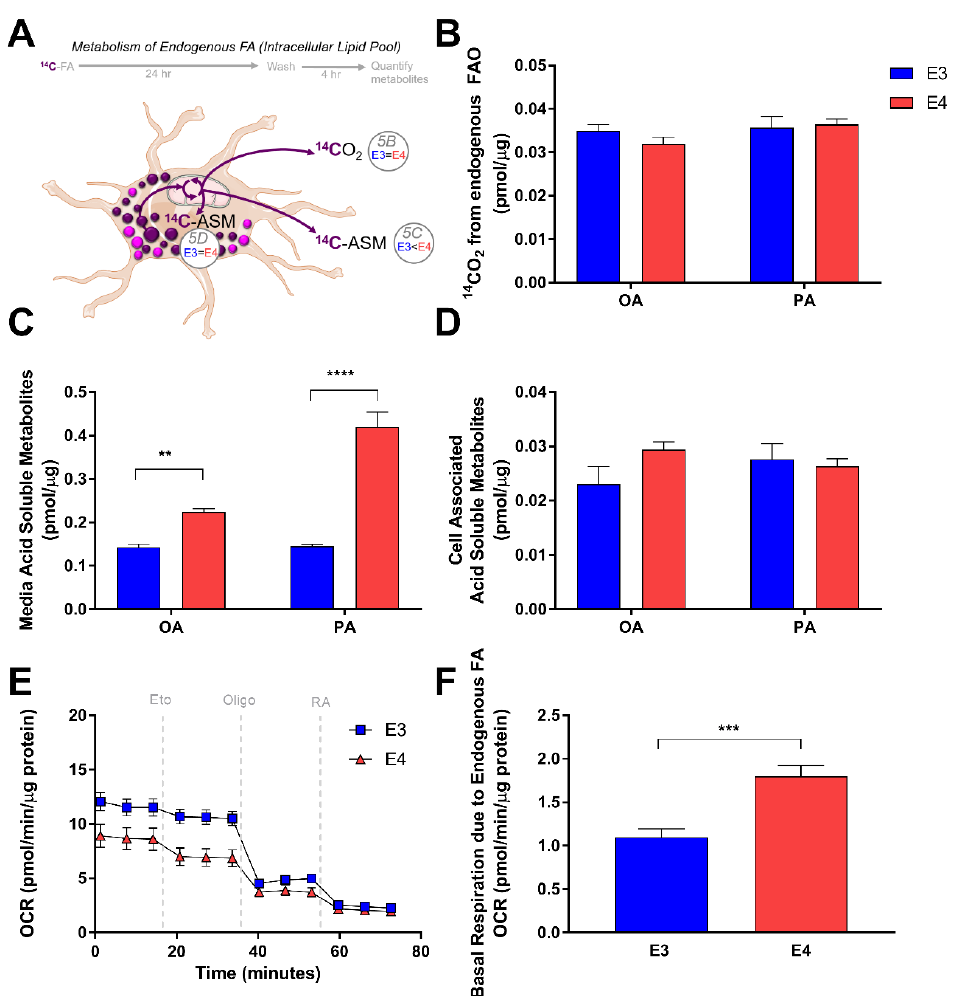
Figure 5. E4 astrocytes oxidize more endogenous fatty acids. ( A ) Schematic and time-course of pulse-chase experiment to determine oxidation of endogenous fatty acids.. ( B ) E3 and E4 astrocytes were treated with 1 µ Ci/mL [1- 14 C] oleate (OA) or [1- 14 C] palmitate (PA) combined with